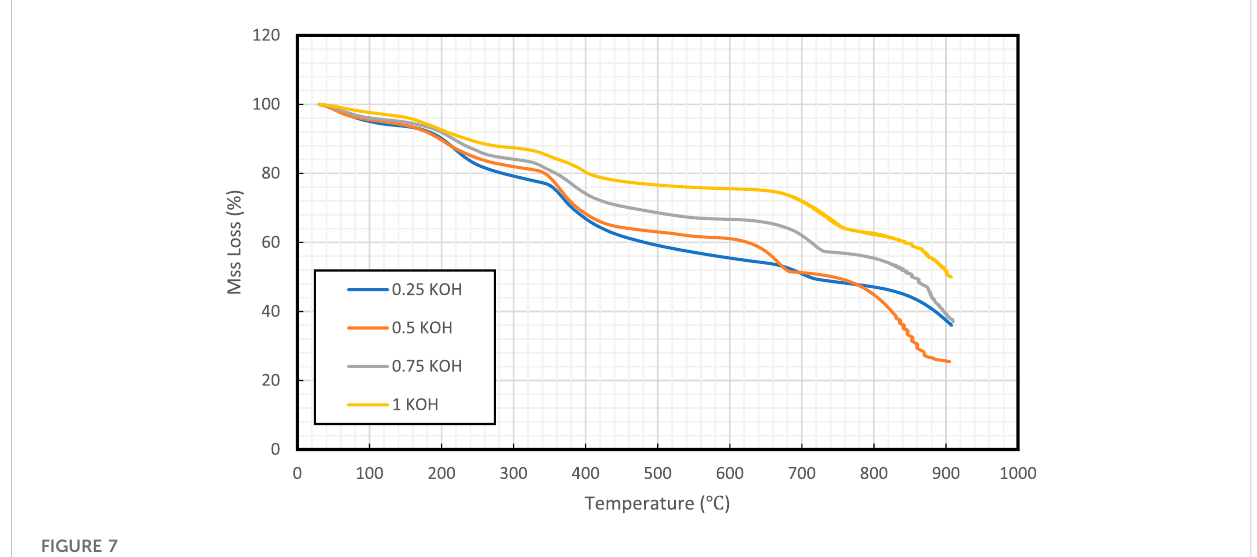
Thermal stability analysis plots for the samples vary in